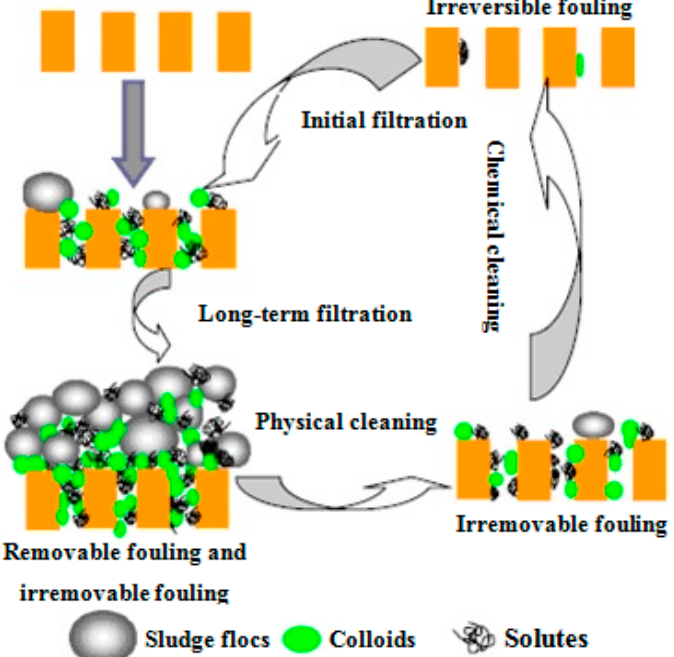
Figure 4. Fouling and cleaning. Reproduced with permission from Reference [3]. Copyright 2009